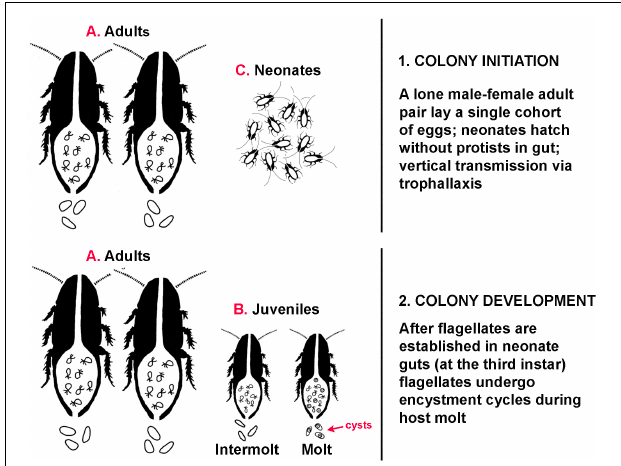
FIGURE 2 | Transmission dynamics during colony ontogeny in the subsocial wood feeding cockroach Cryptocercus . (1) Colony initiation. Adults (A) do not molt, trophozoites are present in the gut, no cysts are present in the feces. Neonates (C) hatch without protists in the gut. (2) Colony development. Trophozoites are present in the gut of adults (A) and juveniles (B) ; cysts are present in the gut and feces of molting